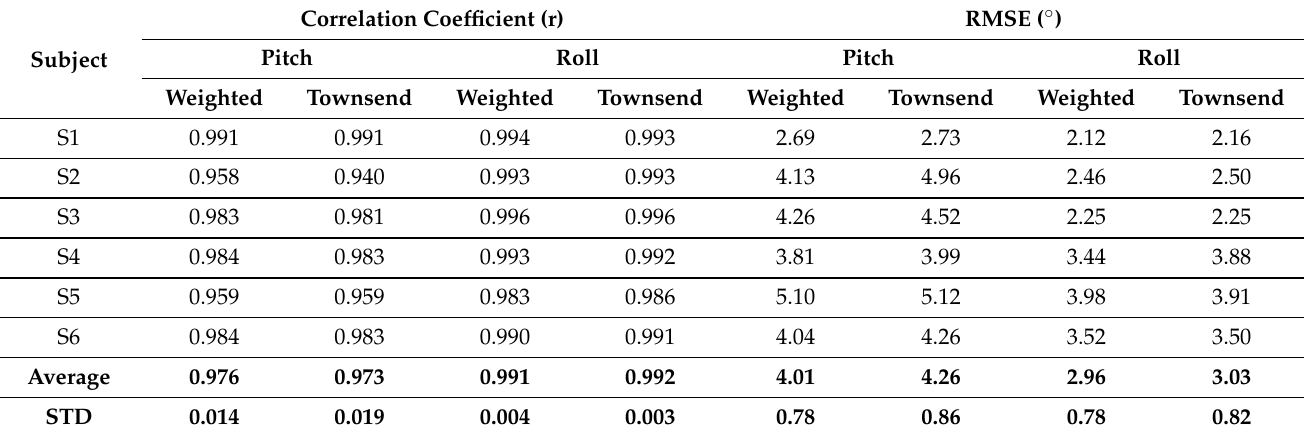
Table 2. Correlation coefficients (r) and root mean squared error (RMSE) from the motion capture calibration process. Individual results from each subject is shown along with the bolded summary statistics.